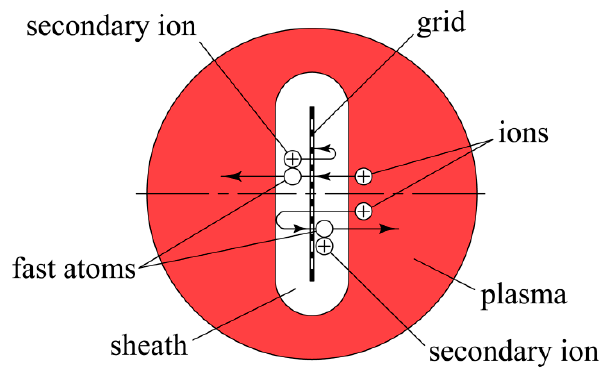
Figure 7. Schematic of fast atoms production in the sheath of a flat grid immersed in plasma.